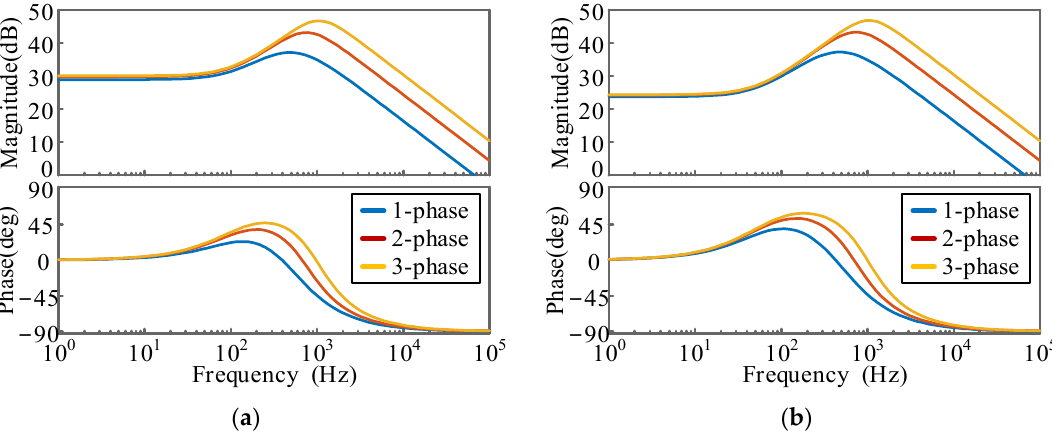
Figure 3. Comparison of different phases’ transfer function for i bat. ( a ) Bode diagram at full load. ( b ) Bode diagram at ahlf load.